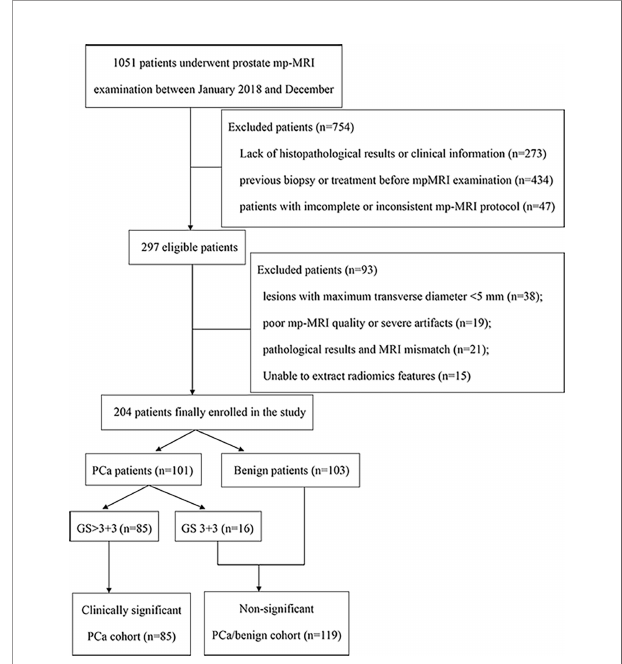
FIGURE 1 | Flow chart of patients ’ recruitment